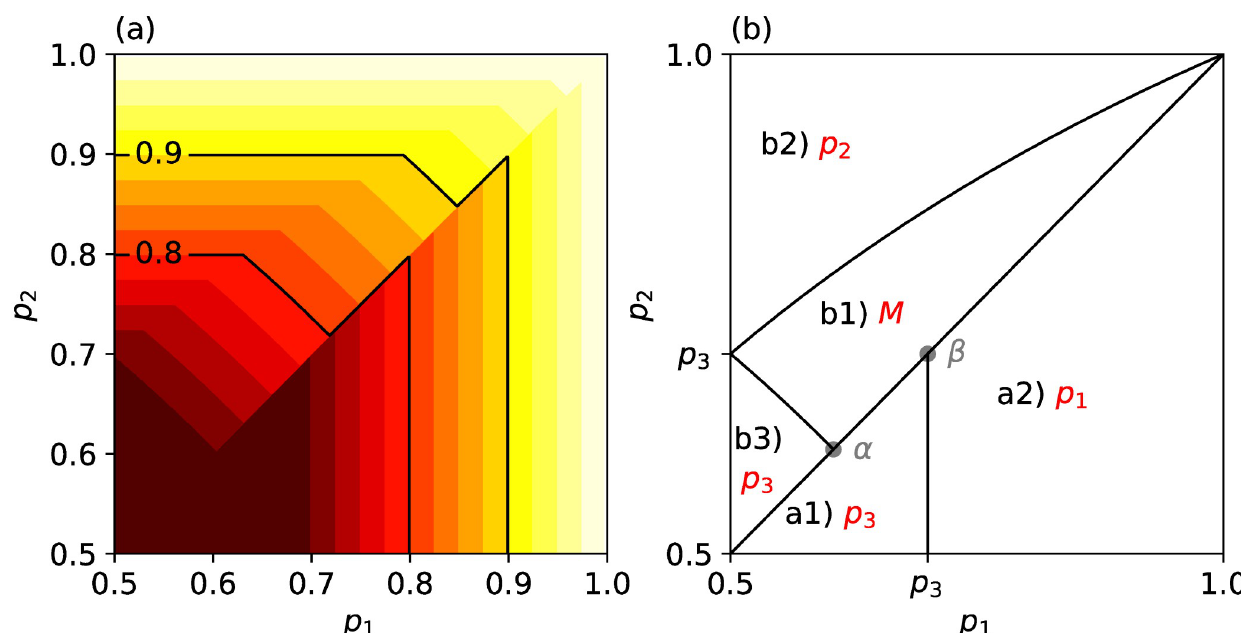
Fig 3. Mean performance of the third individual E[ π 3 ( S 2 , T 2 , R 2 , X 3 )] in sequential decision-making. (a) E[ π 3 ( S 2 , T 2 , R 2 , X 3 )] in sequential decision- making when p 3 = 0.7 is exhibited by contours. The horizontal and the vertical axes show the abilities p 1 and p 2 of the first and second individuals, respectively. The brighter colour stands for the higher mean performance. (b) E[ π 3 ( S 2 , T 2 , R 2 , X 3 )] is shown by red text. The horizontal and vertical axes are the same as that in panel (a). Each region corresponds to each case of a1) to b3) in Fig 2. The coordinates of α and β are p(cid:0) � p(cid:0) � ffiffiffiffiffiffiffiffiffiffiffiffiffi ffiffiffiffiffiffiffiffiffiffiffiffiffi ffiffiffiffiffi ffiffiffiffiffi p ffiffiffiffiffi p p ffiffiffiffiffi p ; and ( p 3 , p 3 ), = þ 1 (cid:0) p = þ 1 (cid:0) p p 3 p 3 p 3 p 3 3 3